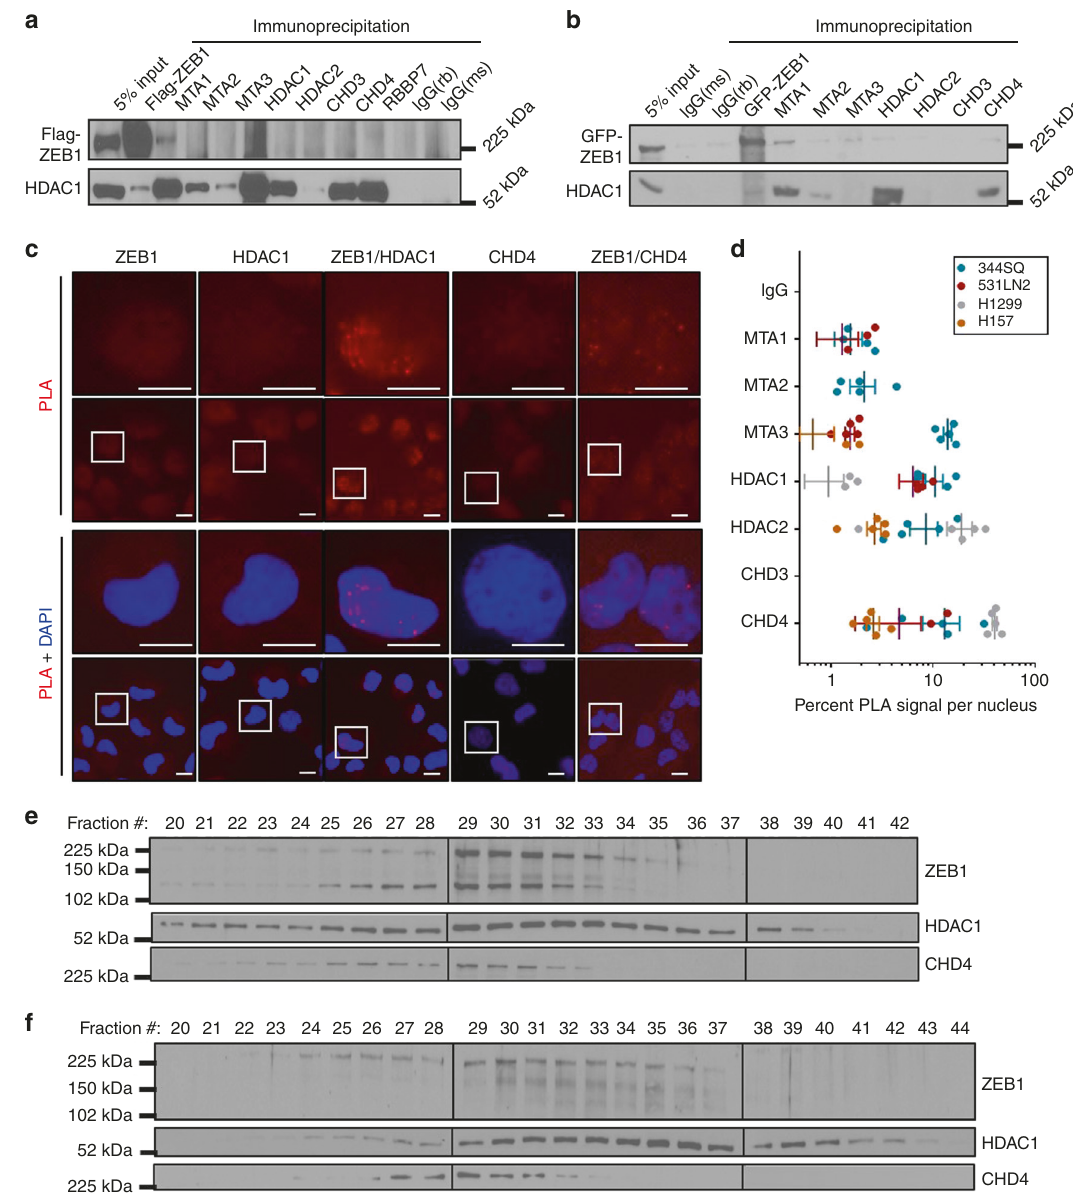
Fig. 2 ZEB1 interacts with the NuRD complex. Co-immunoprecipitation of Flag-ZEB1 in HEK/293 Flp-In ( a ), or co-IP of GFP-ZEB1 in the murine cell line 344SQ (5% input indicates whole cell lysate) ( b ). Blots for HDAC1 and ZEB1 (Flag-tagged or GFP-tagged) con fi rm ZEB1 interacts with HDAC1 and MTA1. c Validation of ZEB1/NuRD complex interaction by proximity ligation assay (PLA). Human and murine NSCLC cell lines were fi xed, permeabilized, blocked, and probed with species speci fi c primary antibodies directed against ZEB1 and NuRD complex members. PLA was performed utilizing the Duolink In Situ Red Starter kit (Sigma). Representative PLA signal and nuclear staining (DAPI) in the human NSCLC cells H157 are shown. Red signal signi fi es interaction between ZEB1 and HDAC1. Scale bars represent 100 µ m. d Quanti fi cation of mean PLA signal per cell in various murine and human cell lines; standard deviation n = 5. Results from gel fi ltration conducted in e 344SQ and f H157 showing ZEB1 elutes in fraction number 25 – 35, corresponding with a megadalton-sized complex. Blots of the NuRD complex members CHD4 and HDAC1 con fi rm that the NuRD complex members concurrently reside within fractions 25 – 35. Superose column standards: F47/48 = 669 kDa, F51 = 440 kDa, F58 = 158 kDa, F61 = 44